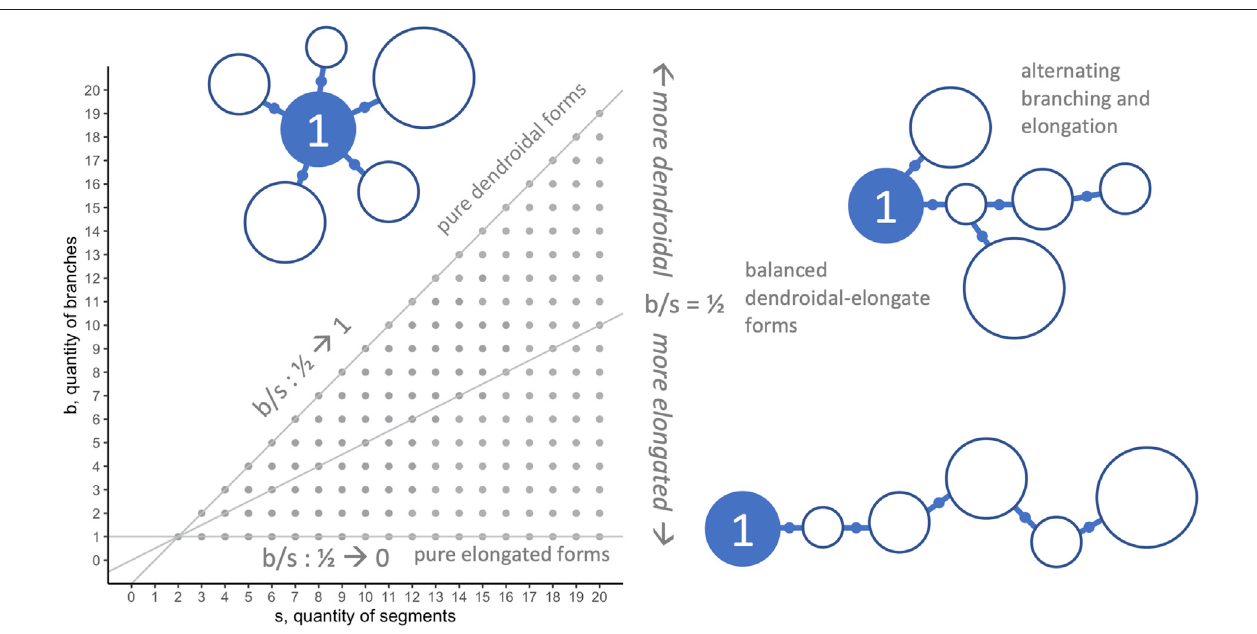
FIGURE 3 | Morphospace: limits and morphological con fi gurations. Because they represent important aspects of the overall morphological con fi guration (see Figure 1 ) and development (see Figure 2 ) of the biorobots, the quantity of segments s and branches b were chosen as the dimensions in this 2D morphospace. This morphospace has limits imposed by development. The upper boundary (gray diagonal) is determined by the developmental rule that one branch has a minimum of two segments, hence s > b . The lower boundary (horizontal gray line at b (cid:1) 1) is determined by the developmental rule that elongation may proceed on a single branch untilresourcesaredepletedandtheagent ’ sdevelopmentiscomplete.Notethattheright-handsideofthemorphospacehasnolimitas fi guredhere,withformsof s > 20 and b > 20